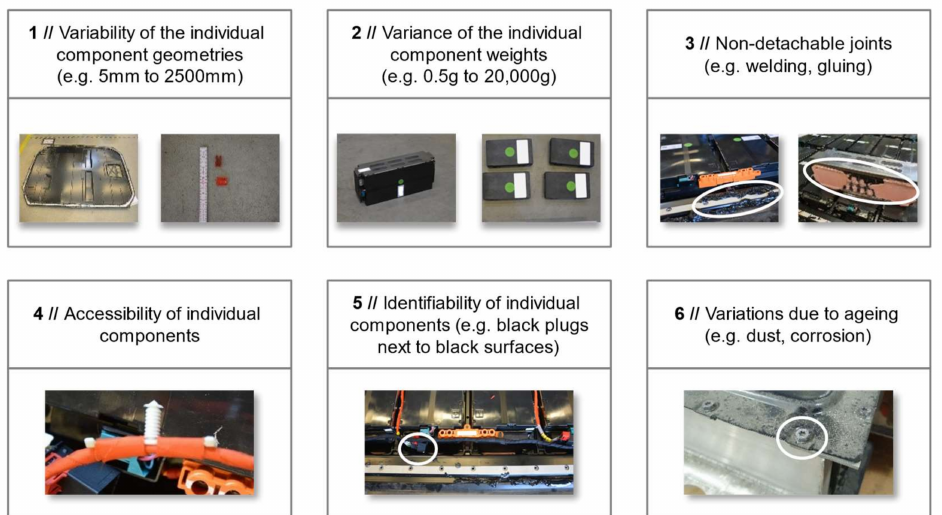
Figure 4. Common challenges that are caused by the product design for the process automation of battery pack disassembly (1, 2, 3, 4, 5: Audi e-tron 50 battery pack; 6: BMW i3 battery